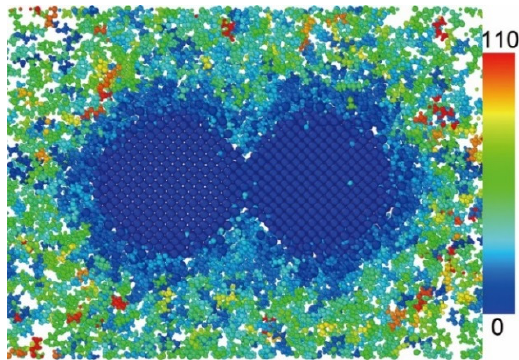
Figure 16. Displacement distribution of sliced double sphere model (unit: Å).